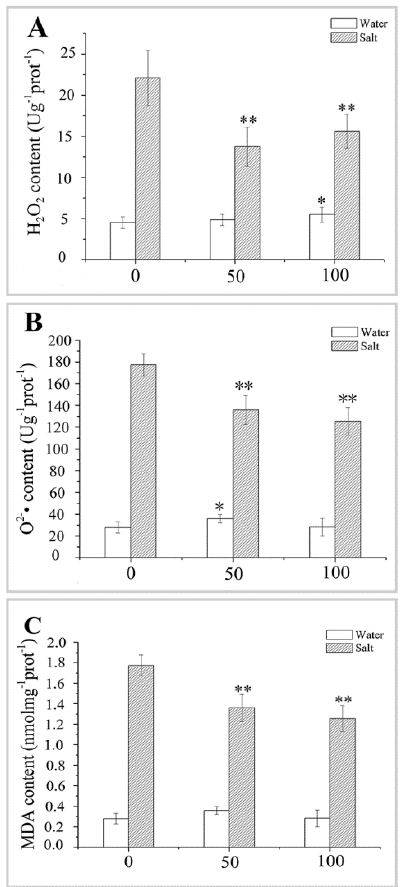
Figure 6. Effect of pretreating with different concentrations of melatonin (MT) on the changes of ROS in leaves of naked oat seedlings under salt stress. ( A ) Hydrogen peroxide (H 2 O 2 ) content; ( B ) superoxide anion (O 2 • – ) content; and ( C ) malondialdehyde (MDA) content. Values are mean ± standard deviation ( n = 3). 0, 50, and 100 represent MT concentration ( µ M) in Figure 6. Asterisks; * and ** indicate significant difference ( p < 0.05 and p < 0.01) compared with mock coating (0 µ M). Measurement was carried out after six days of the salt plus MT pretreatmemt.